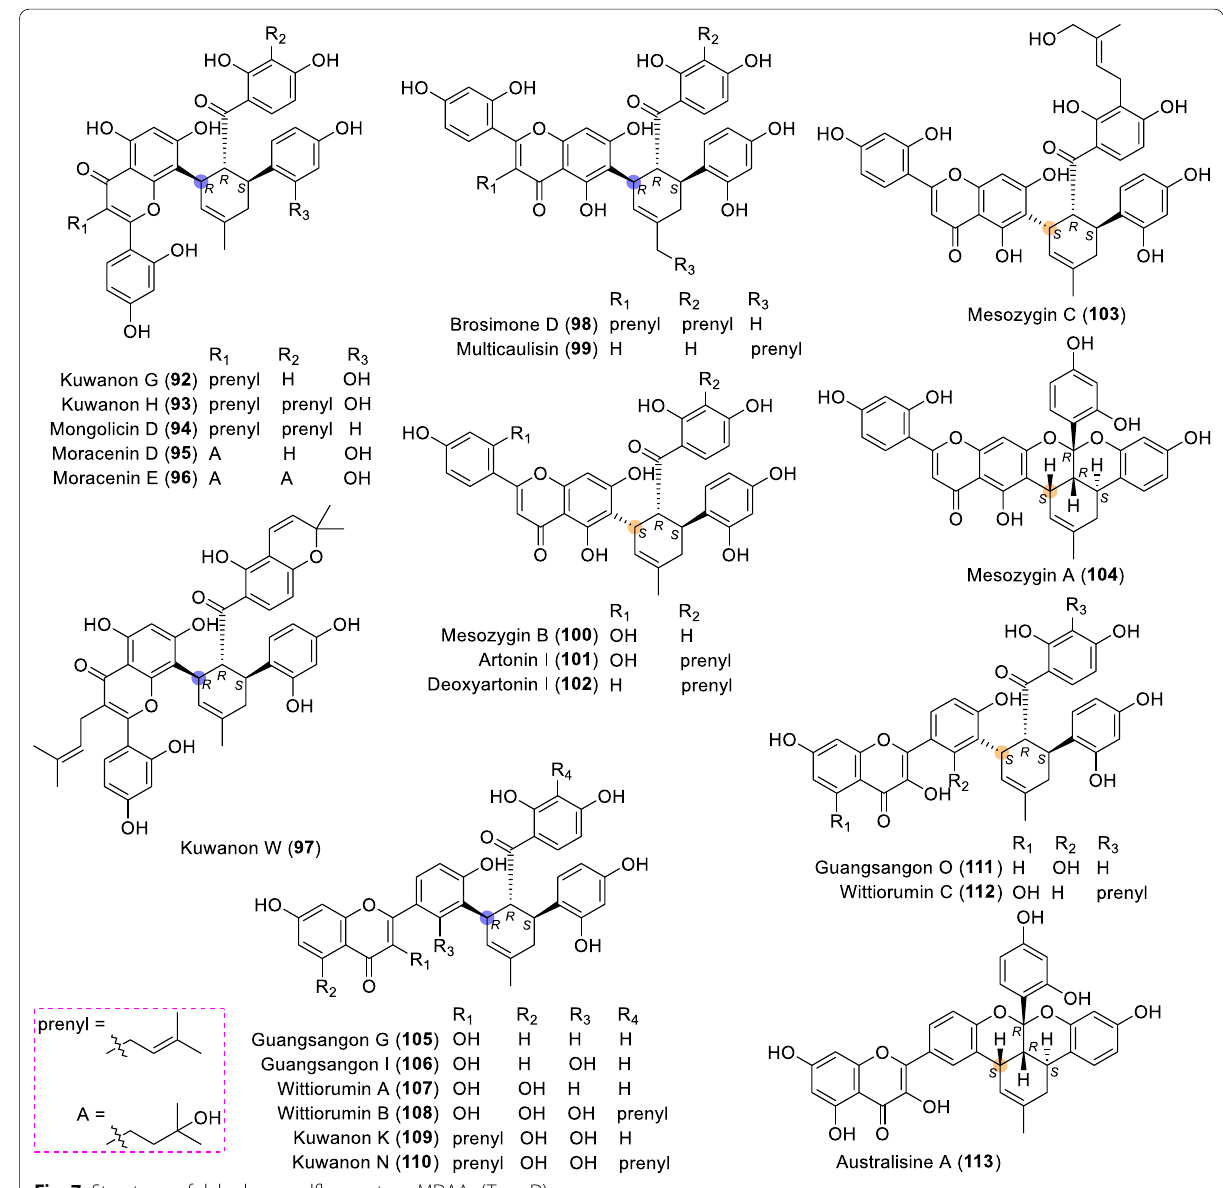
Fig. 7 Structures of dehydroprenylflavone type MDAAs (Type